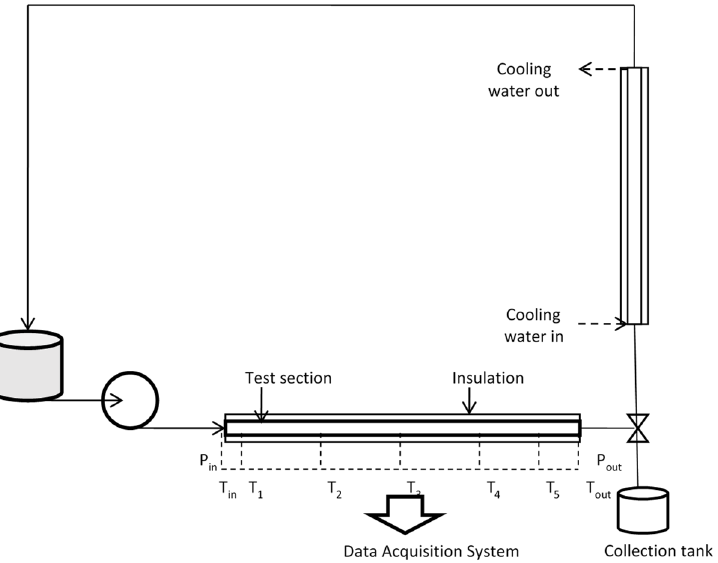
Figure 22. Schematic of the forced convection study loop [49]. Reproduced with permission